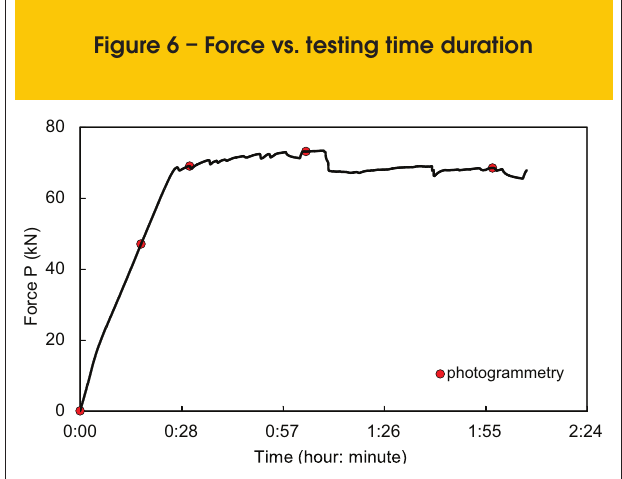
Figure 6 – Force vs. testing time duration